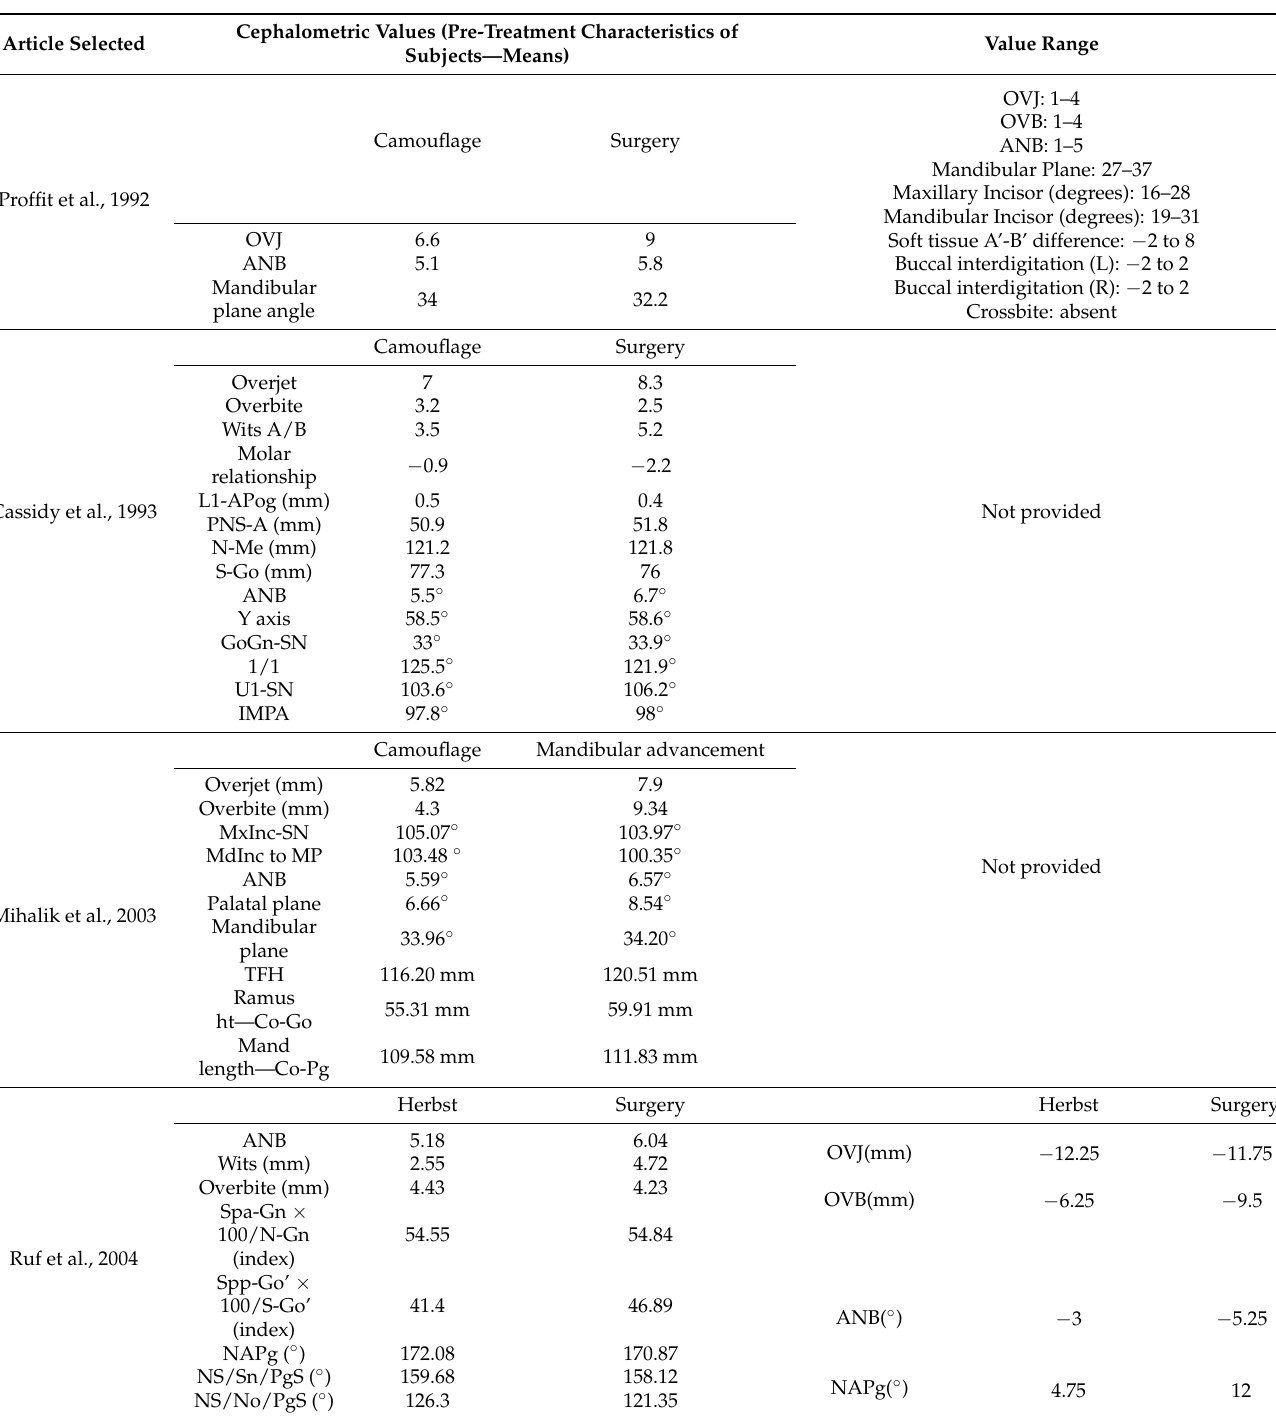
Table 3. Cephalometric values and ranges for decision-making in the selected